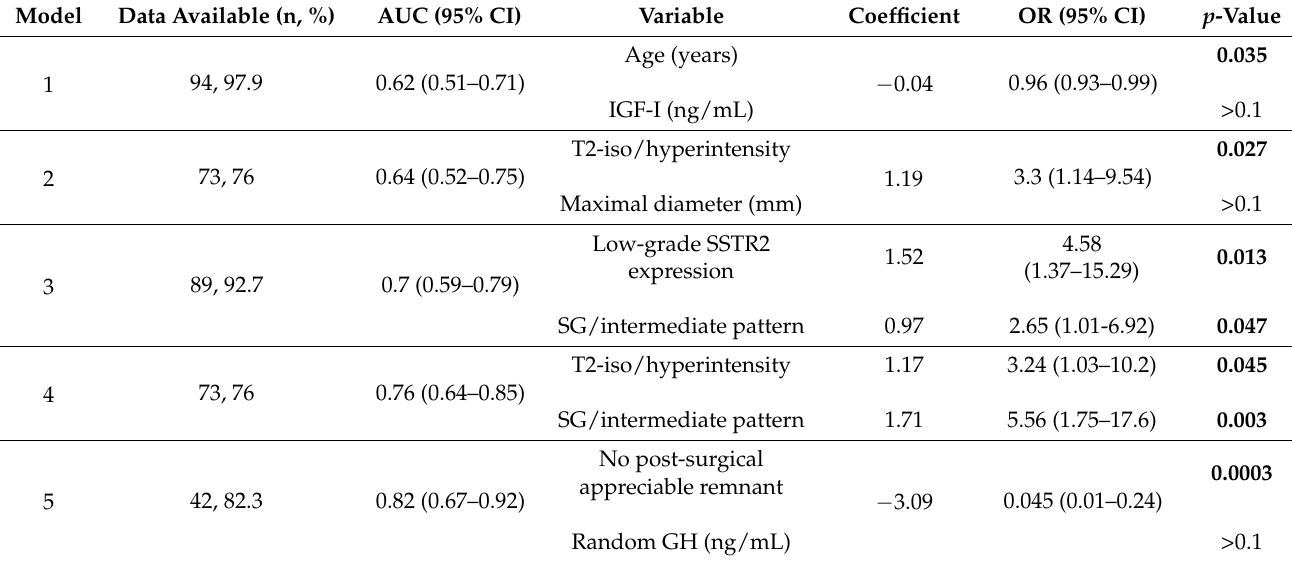
Table 3. Bivariate logistic regression analyses on the most promising predictors of resistance to fg-SRL, identified by descriptive statistics.